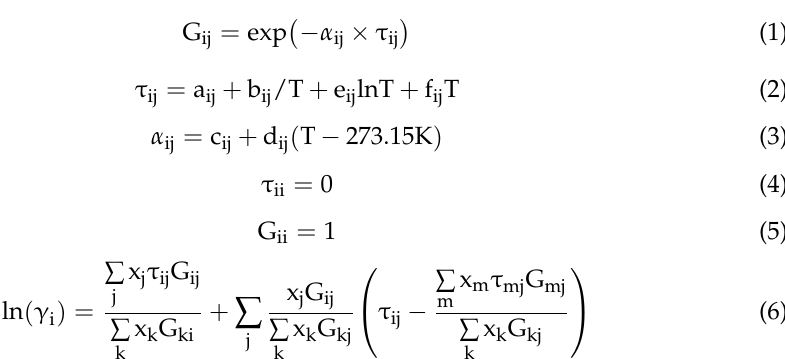
Table 1. NRTL model parameters for acetic acid/isoamyl alcohol/isoamyl acetate/water mixtures (with permission from [8]). i Water * Water Water Acid Acid Alcohol j Acid * Alcohol Acetate Alcohol Acetate Acetate a ij 3.3293 1.5598 0.3194 0.4521